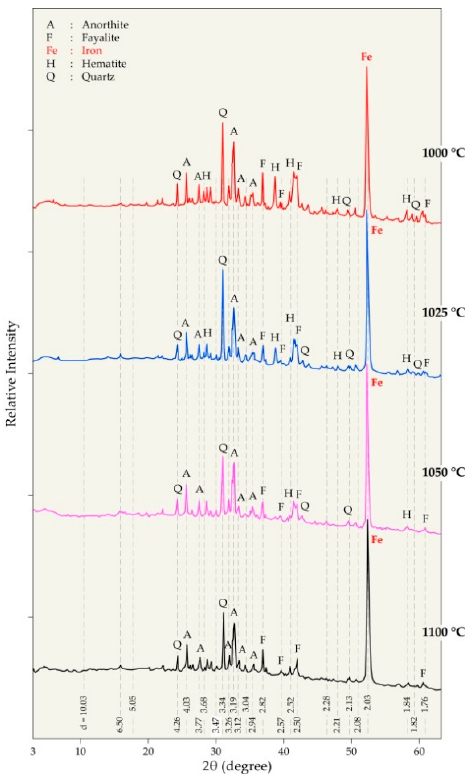
Figure 11. XRD diffractograms of the residues obtained during the treatment of pellets from 1000 °C to 1100 °C at 30 min.